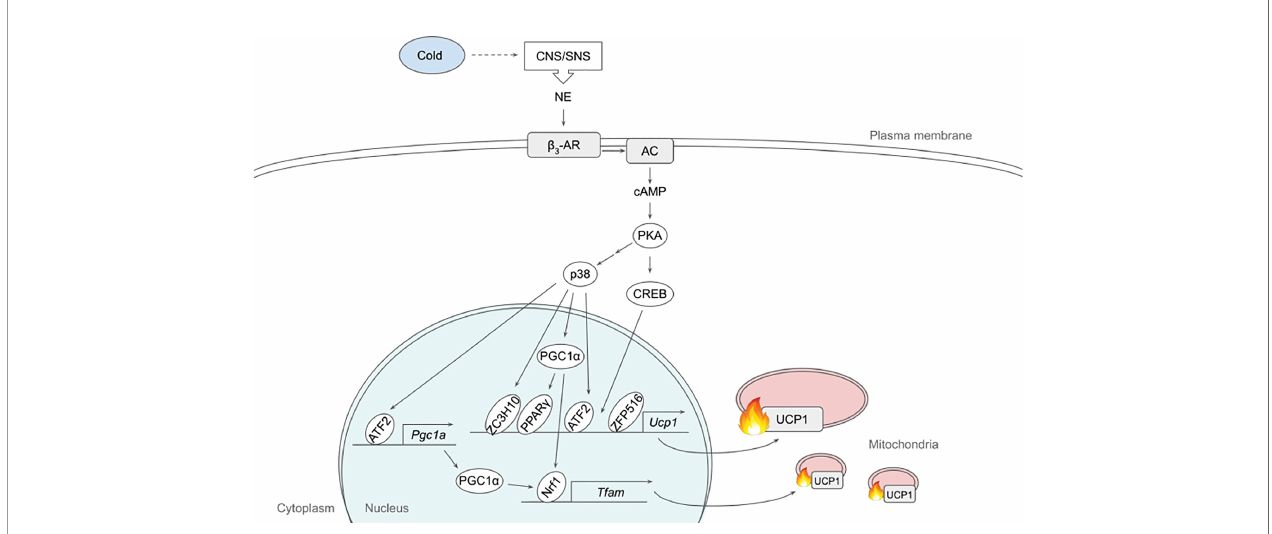
FIGURE 1 | Schematic model of b 3 -adrenergic signaling pathway that promotes thermogenesis in adipocytes. Cold stimulates CNS/SNS to secrete NE that binds b 3 -AR, which then activates AC producing cAMP. cAMP in turn activates PKA that has a variety of downstream targets, including transcription factors to upregulate thermogenic gene expression. See text for details. AC, adenylate cyclase; ATF2, activating transcription factor 2; b 3 -AR, b 3 -adrenergic receptor; CNS, central nervous system; CREB, cAMP response-element binding protein; ETC, electron transport chain; FFA, free fatty acid; IRF4, interferon regulatory factor 4; NE, norepinephrine; NRF1, nuclear respiratory factor 1; PGC1 a , peroxisome proliferator activated receptor g coactivator a ; PKA, protein kinase A; PPAR g , peroxisome proliferator activated receptor g ; SNS sympathetic nervous system; TCA, tricarboxylic acid; TFAM, mitochondrial transcription factor A; UCP1, uncoupling protein 1; ZC3H10, zinc fi nger CCCH-type containing 10; ZFP516, zinc fi nger protein